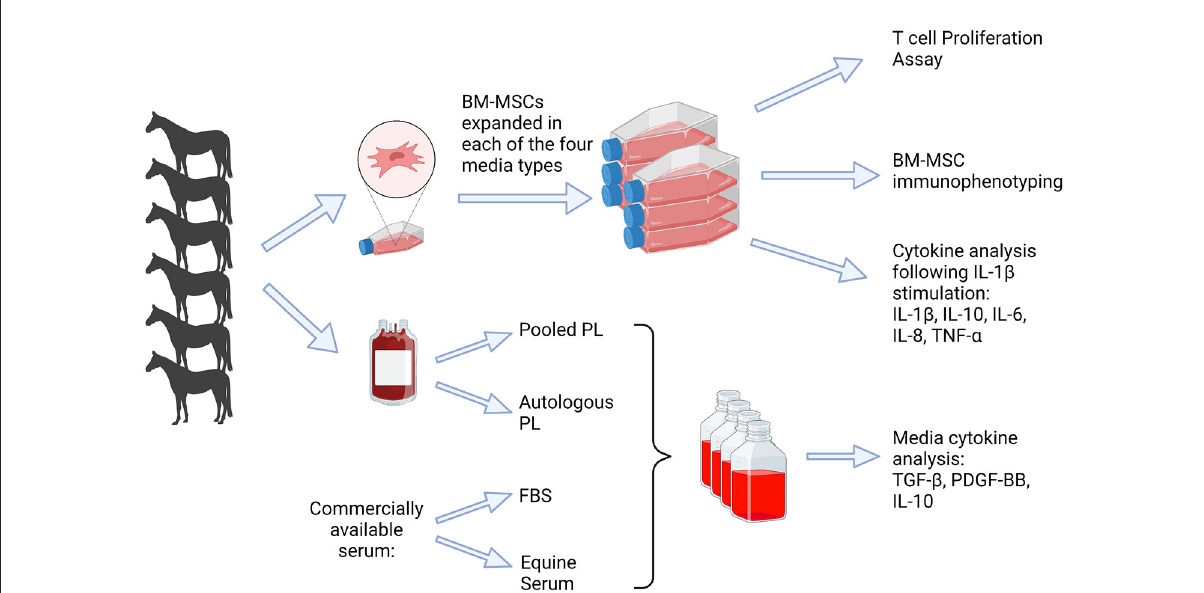
FIGURE1 Depiction of study design. Blood was obtained ( n = 6) to produce platelet lysate, which was used for APL and PPL containing media. Bone marrow was obtained for isolation of BM-MSCs and culture expanded in each of four media types, FBS, APL, PPL, and ES. Analyses included cytokine quantification in the media, T cell proliferation assay, BM-MSC immunophenotype, and cytokine analysis. FBS, fetal bovine serum; PL, platelet lysate; BM-MSCs, bone marrow-derived mesenchymal stem cells. This graphic was created with